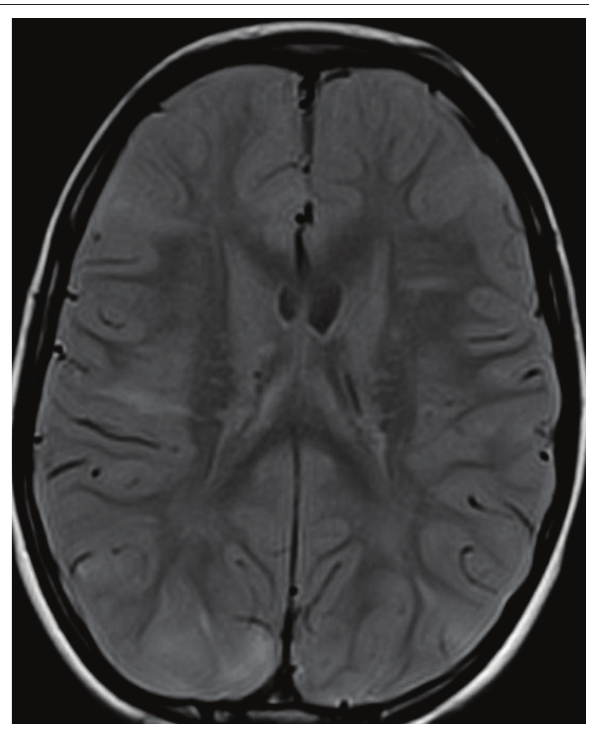
FIGURE 2: Axial FLAIR MR image.